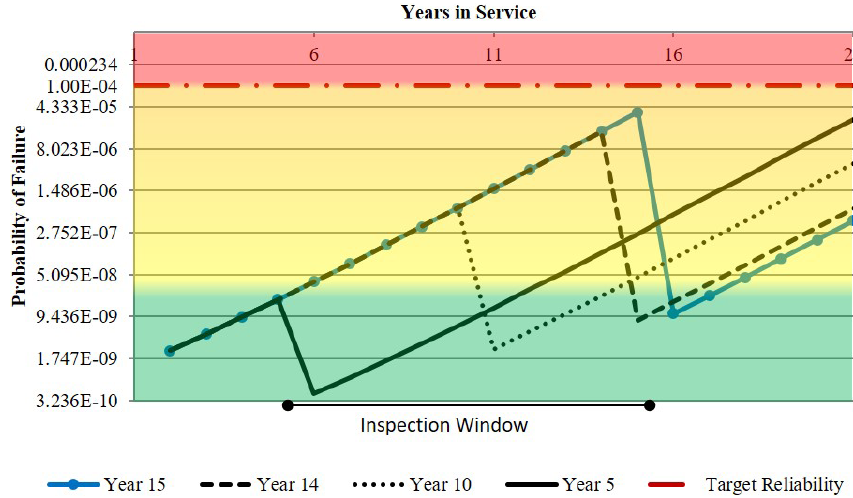
Figure 28. Crack growth curves of case study through thickness in a plate considering different first inspection times.